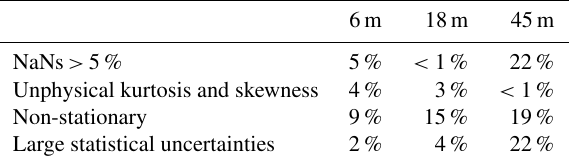
Table 1. Percentage of the records between April 1994 and July 1995 from SMW that failed the data-quality